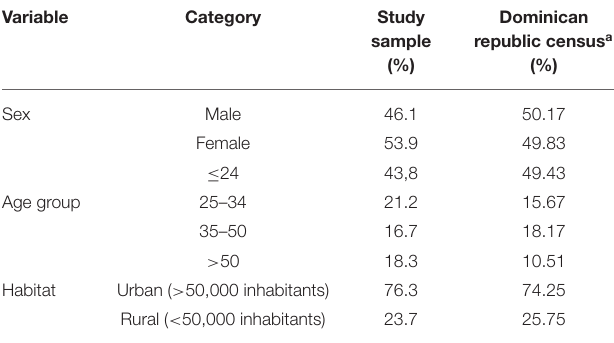
TABLE 2 | Demographic comparisons between the sample features and country-based data. Variable